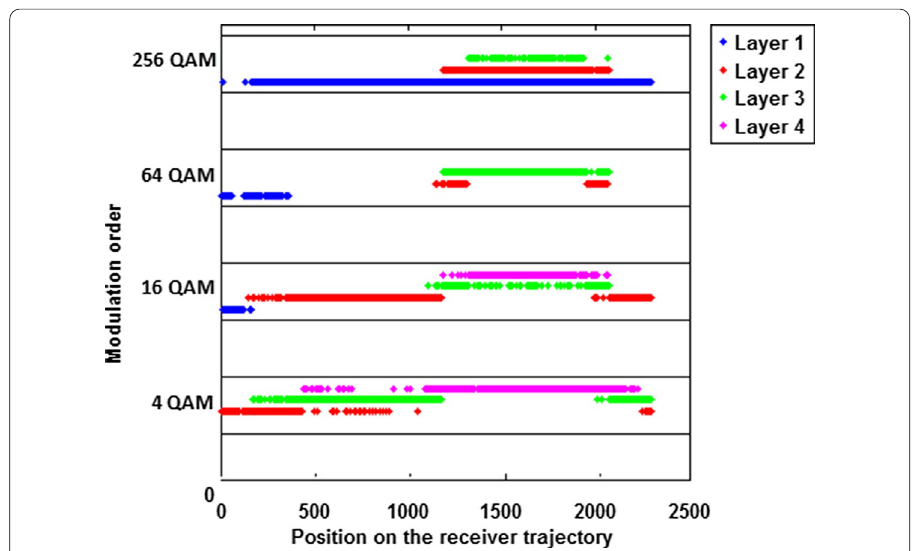
Fig. 15 Modulation order over the reception path. The used modulation orders in each sub-channel and the number of transmitted layers over the reception